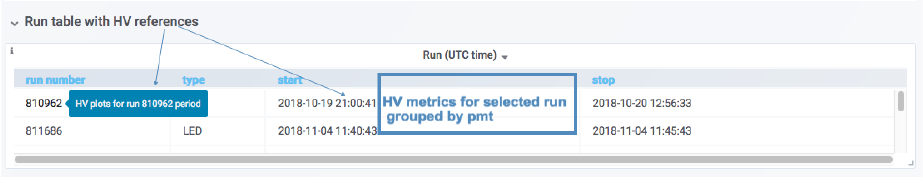
Figure 5. “Run table with HV reference” panel.